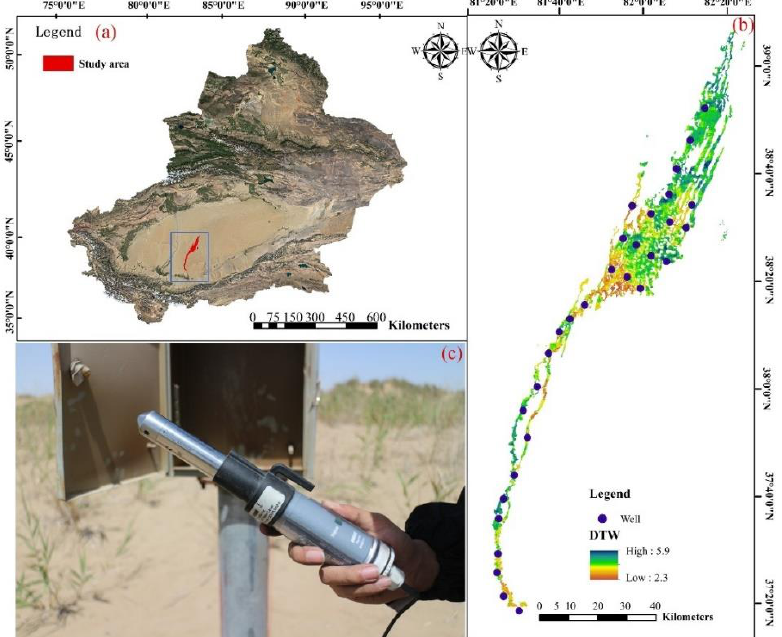
Figure 1. Location map of the research area ( a ) Xinjiang, ( b ) Study area, ( c ) Groundwater observation wells and HOBO instruments.